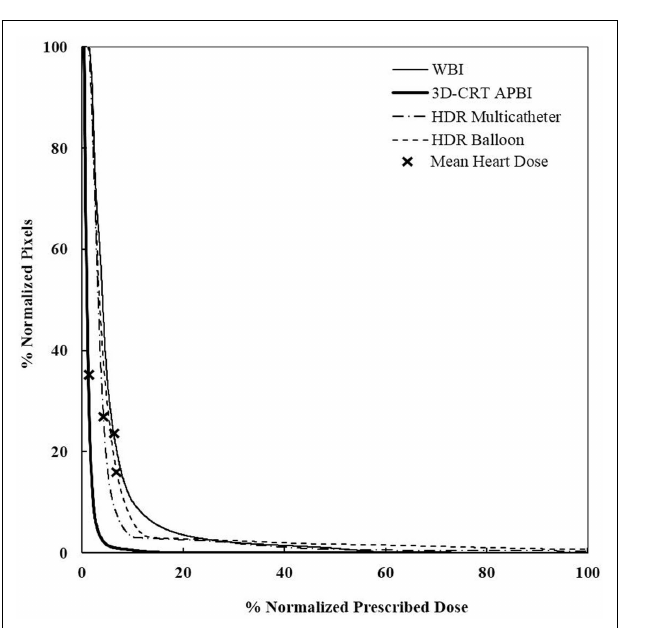
FIGURE 8 | Cumulative DVHs for various tumor locations andAPBI techniques .There is no impact of location for 3D-CRT as opposed to HDR